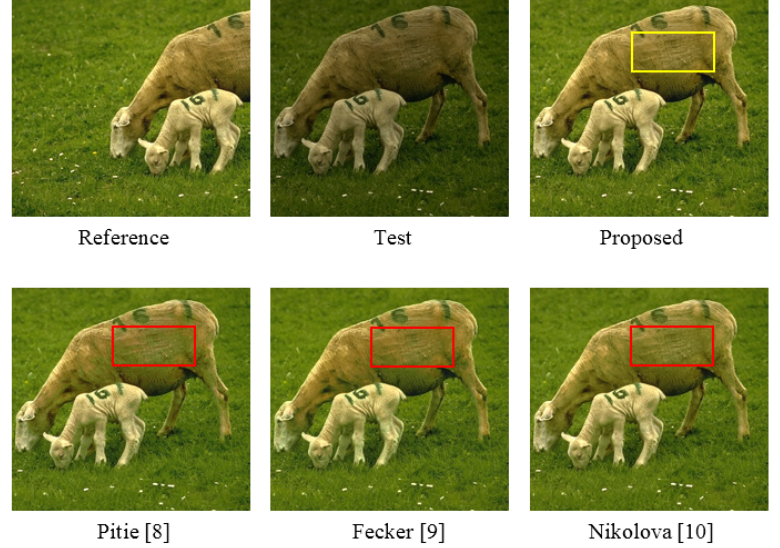
Figure 5. Comparison for the synthetic image pair. Image Source: courtesy of the authors and databases referred on [2,14].